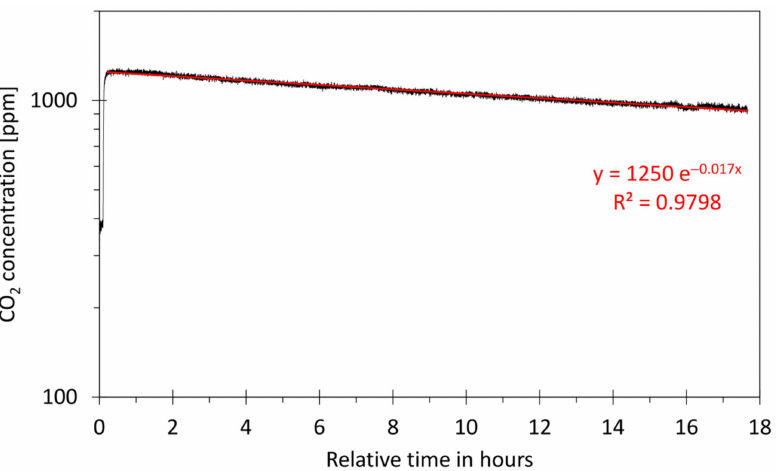
Figure 6. Exponential decay of CO 2 over time due to small leakages in the closed box. The experiment was performed in Cuba (tropical climate). From this experiment, the air exchange rate can be